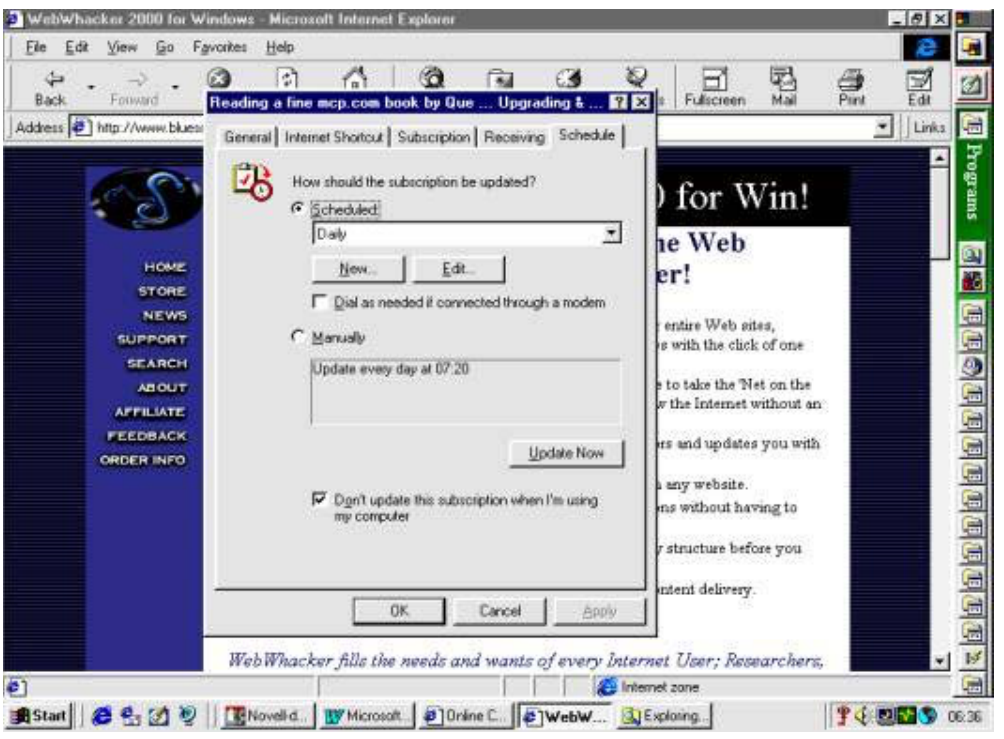
Figure 1 Webcasting set-up screen in Internet